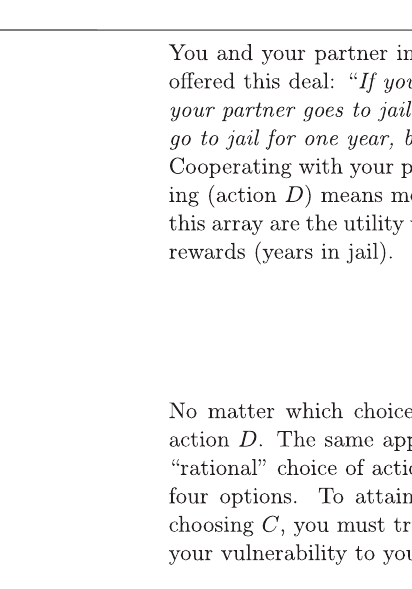
FIGURE 3 | The Prisoner ’ s dilemma (Axelrod,